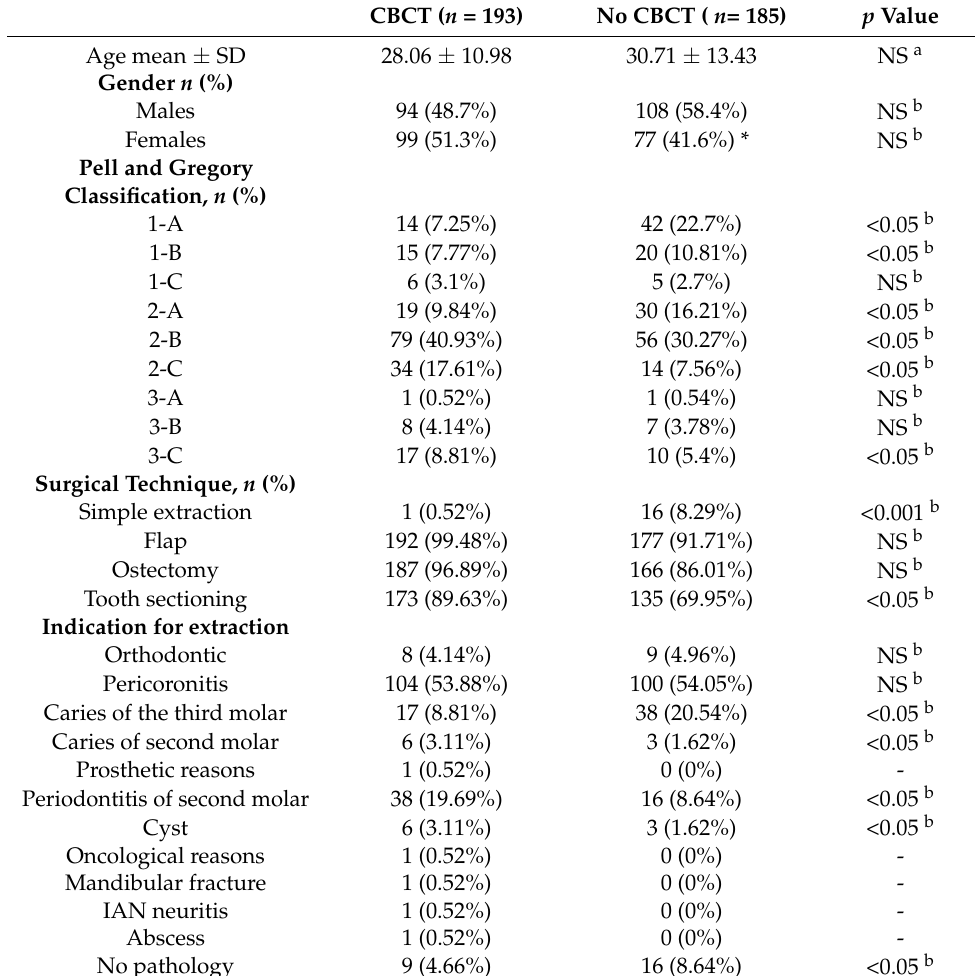
Table 2. Characteristics of patients with Cone Beam Computed Tomography (CBCT) vs. patients with 2D X-rays only (Orthopantomography,